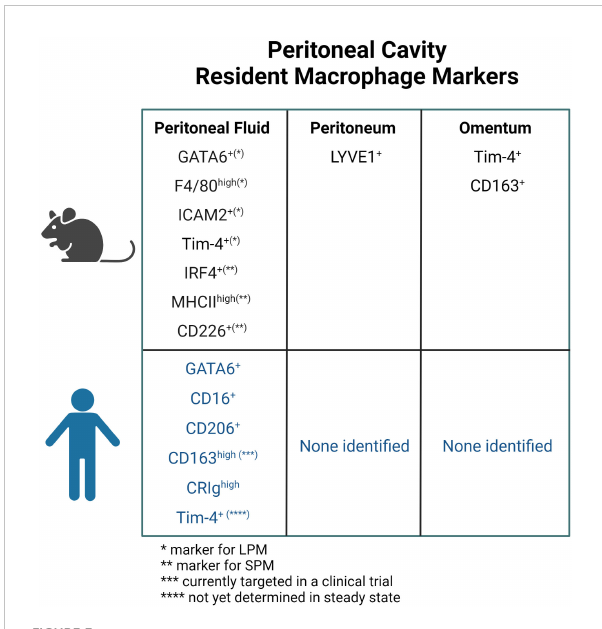
FIGURE 3 Markers for resident macrophage in the peritoneal fl uid, peritoneum, and omentum in mice and human. ICAM, intracellular adhesion molecule; LPM, large peritoneal macrophage; SPM, small peritoneal